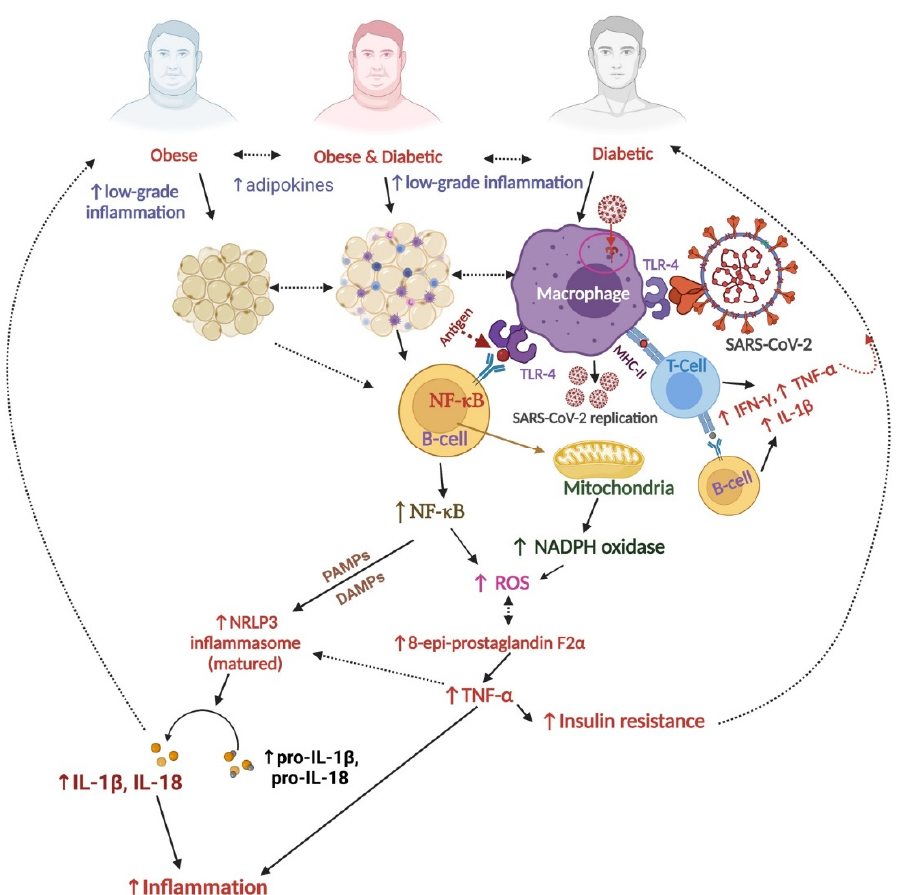
Figure 1. Correlation between SARS-CoV-2, oxidative stress, diabetes, and obesity. Abbreviations: ↑ : increase; ROS, reactive oxygenated species; TNF- α , tumor necrosis factor α , TLR, Toll-like receptor; IL, interleukin; NADPH, nicotinamide adenine dinucleotide phosphate oxidase; IFN γ , gamma interferon; NF- κ B, nuclear factor-kappa B; NLRP3, nucleotide-binding oligomerization domain-like receptor family pyrin domain containing 3 inflammasome; PAMPs, pathogen-associated molecular patterns; DAMPs, damage-associated molecular patterns; MHC-II, major histocompatibility complex class II. (The figure was made with www.biorender.com, accessed on 13 December